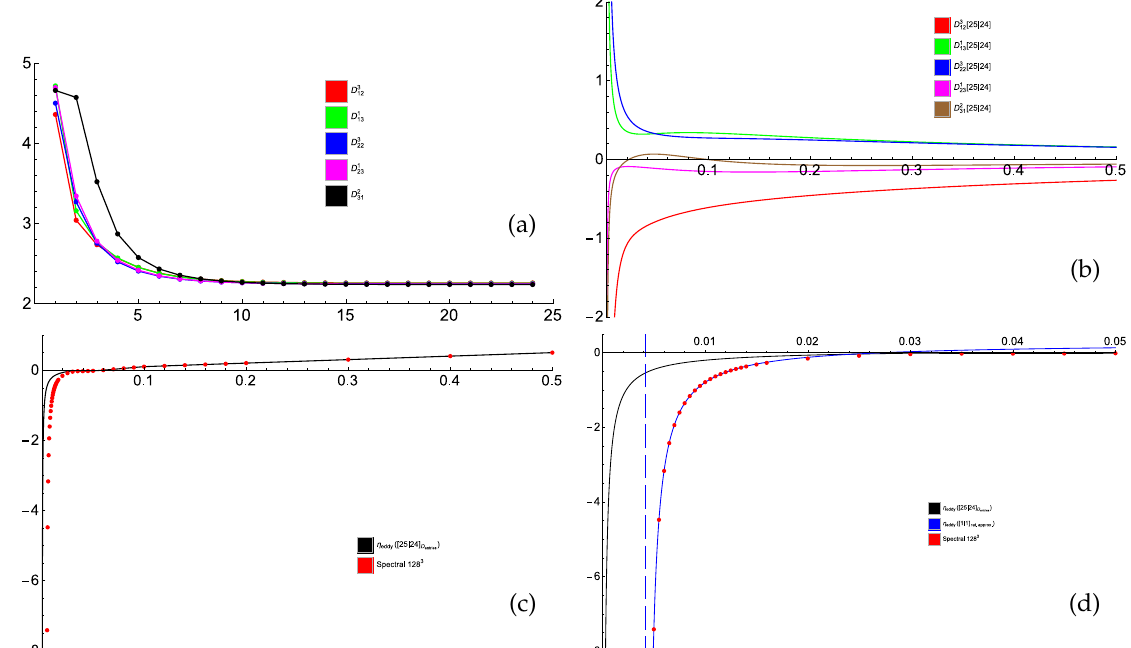
1/2 (vertical axis) versus n > 0 (horizontal axis) for ( D l ) ( 2 n − 1 ) / ( D l ) ( 2 n + 1 ) Figure 7. The ratios mk mk | | five independent entries of the eddy diffusivity tensor for the flow (54), (55) ( a ). The [25/24] Padé approximants for the five entries D l (vertical axis) versus η (horizontal axis) ( b ) and minimum eddy mk diffusivity (53) (vertical axis) computed using these approximants for varying η (horizontal axis) ( c ). Red dots: minimum eddy diffusivity computed by spectral methods (resolution of 128 3 Fourier harmonics) individually for the respective η values. Zoomed-in view of plot ( c ) for small η (black line) and a hyperbolic fit (blue line) through the 20 spectral eddy diffusivity values for 20 η points in η the interval 0.0045 0.014 step 0.0005 ( d ). The dashed line shows the vertical asymptote of the ≤ ≤ minimum eddy diffusivity at the onset of a small-scale dynamo in the symmetry subspace, where the neutral mode s 3